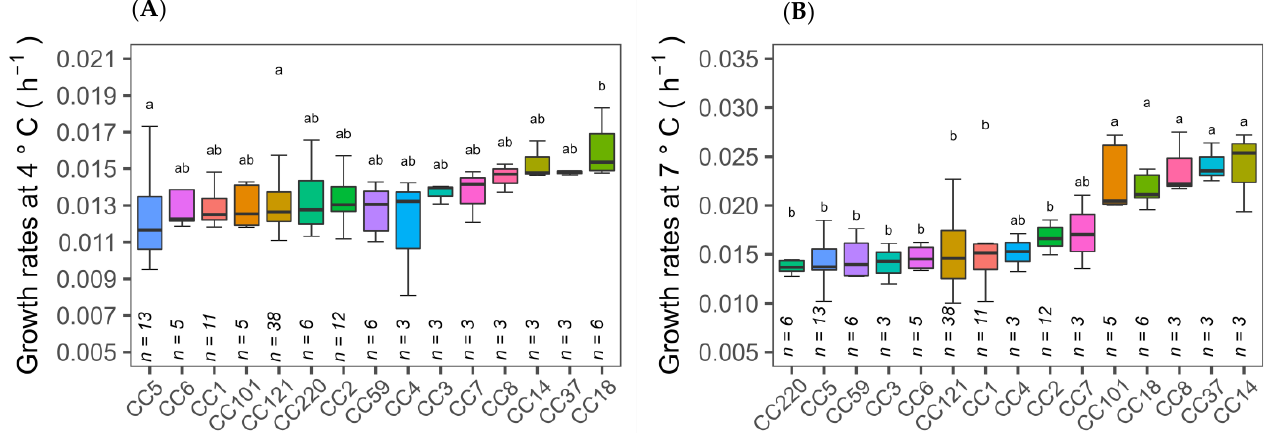
Figure 3. Isolates clustered by optical density determined growth rates at 4 and 7 °C according to CC type ( A , B ). Error bars represent standard deviations of three or more isolates’ growth rate within respective CC type. Clonal complex type with different denoted letters within the same stress are significantly different ( p < 0.05).